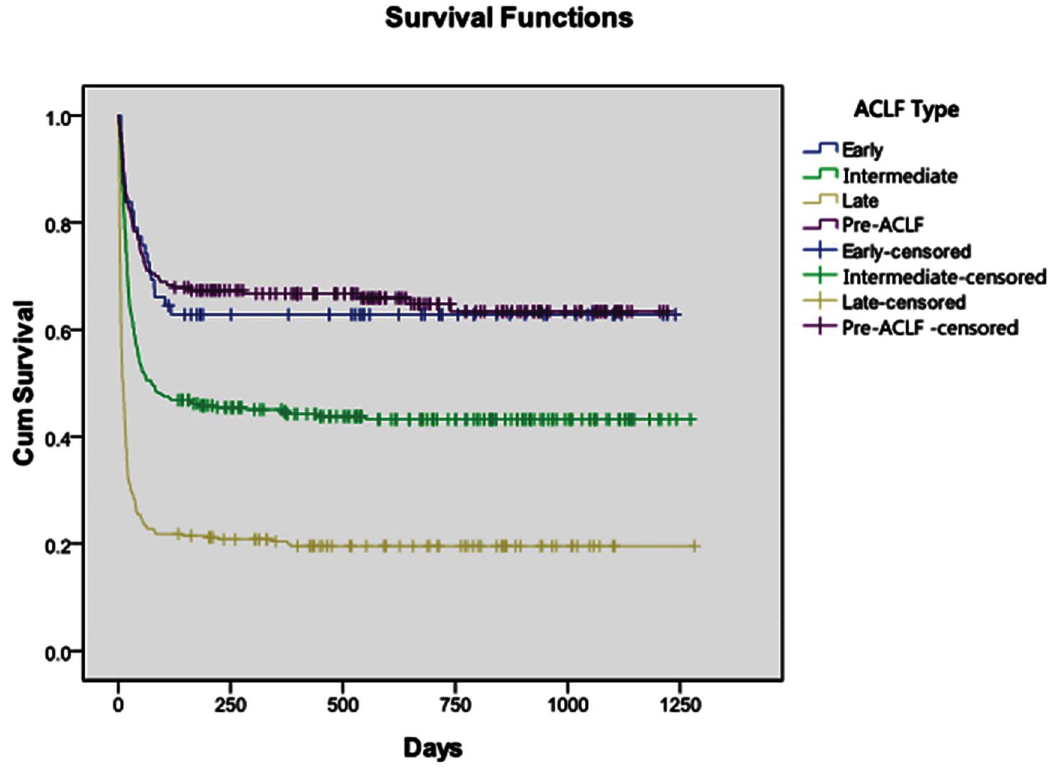
Figure 2. Comparison of actual survival among patients with pre-ACLF, early-stage ACLF, intermediate-stage ACLF and late-stage ACLF. No significant differences existed between patients with pre-ACLF and early-stage ACLF (P . 0.05). However, the difference in survival between pre-ACLF patients and intermediate-stage ACLF patients was statistically significant (P , 0.0001). The difference in survival between intermediate- stage ACLF patients and late-stage ACLF patients was also statistically significant (P , 0.0001).